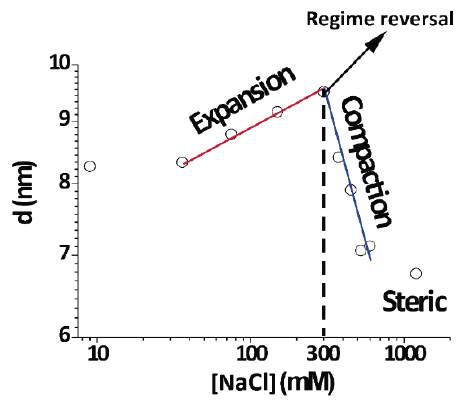
Figure 6. Periodicity ( 𝑑 ) as a function of the IS in double logarithmic plot at 4 °C. The IS dependence of d was clearly non-monotonic and exhibited distinct regimes, indicated with straight lines.